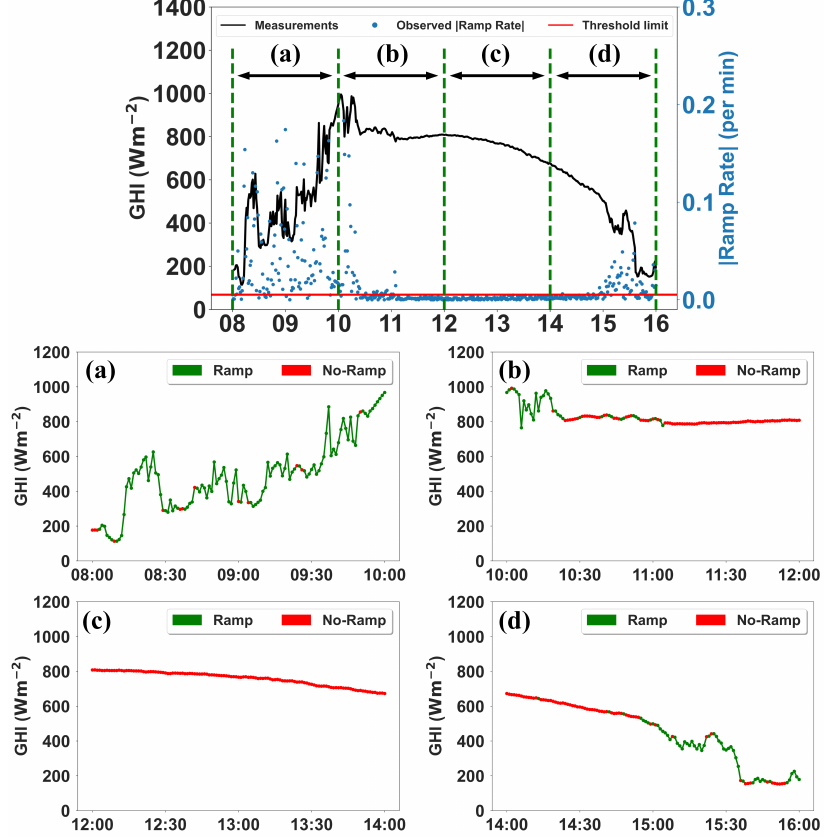
Figure 4. The graph in the upper panel depicts the intra-day GHI variability and the absolute observed ramp rate values at time horizon D = 1min derived from the reference pyranometer. The red horizontal line corresponds to the threshold limit for D = 1min. The lower four plots show the detected ramp events based on ground-based measurements in four time intervals: ( a ) 08:00–10:00, ( b ) 10:00–12:00, ( c ) 12:00–14:00 and ( d )